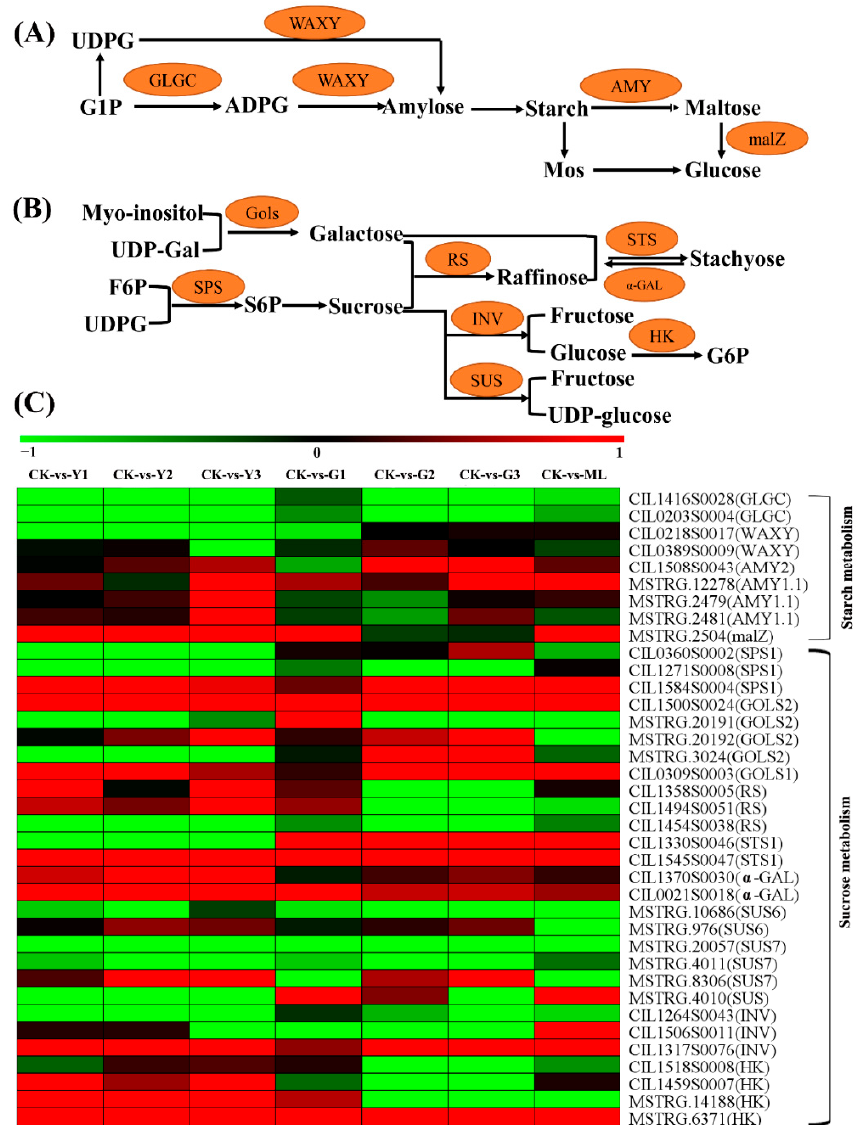
Figure 12. Carbohydrate metabolic pathways. ( A ) Starch biosynthesis and degradation pathway. ( B ) Sucrose biosynthesis and metabolism pathway. ( C ) Heatmap of DEGs of carbohydrate metabolic pathway. Responsive progression of genes expressions under different samples infection with PMV compared CK. Heat maps were drawn using the Log2 ratio (transformed FPKM value of PMV infection/those of CK). Detailed genes and expressions data were provided in Table S19, available as Supplementary Data online. WAXY, granule-bound starch synthase; GLGC, glucose-1-phosphate adenylyltransferase; AMY, alpha-amylase; malZ, alpha-glucosidase; UDPG, UDP-glucose; ADPG, ADP-glucose; G1P, glucose-1P; F6P, fructose 6-phosphate; RS, raffinose synthase; SPS, sucrose phosphate synthase; SUS, sucrose synthase; S6P, sucrose-6-phosphate; HK, hexokinase; STS, stachyose synthase; UDPG, UDP-glucose; UDP-Gal, UDP-galactose; GOLS, galactinol synthase. α -GAL, alpha-galactosidase; INV, beta-fructofuranosidase. The heat maps indicated the upregulation (red) and downregulation (green) of genes in PMV-infected samples compared to CK.